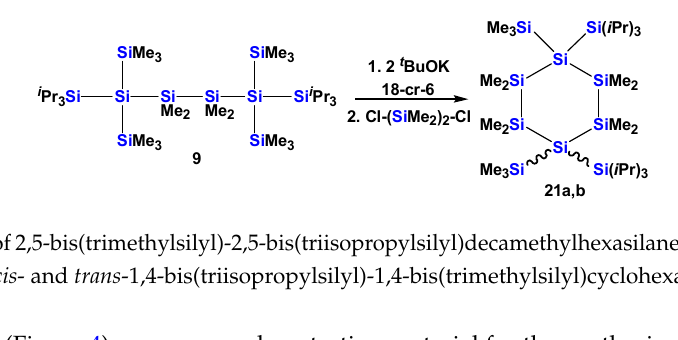
Figure 4. Some new compounds prepared in this study either as starting materials or as subjects for UV-spectroscopic studies.